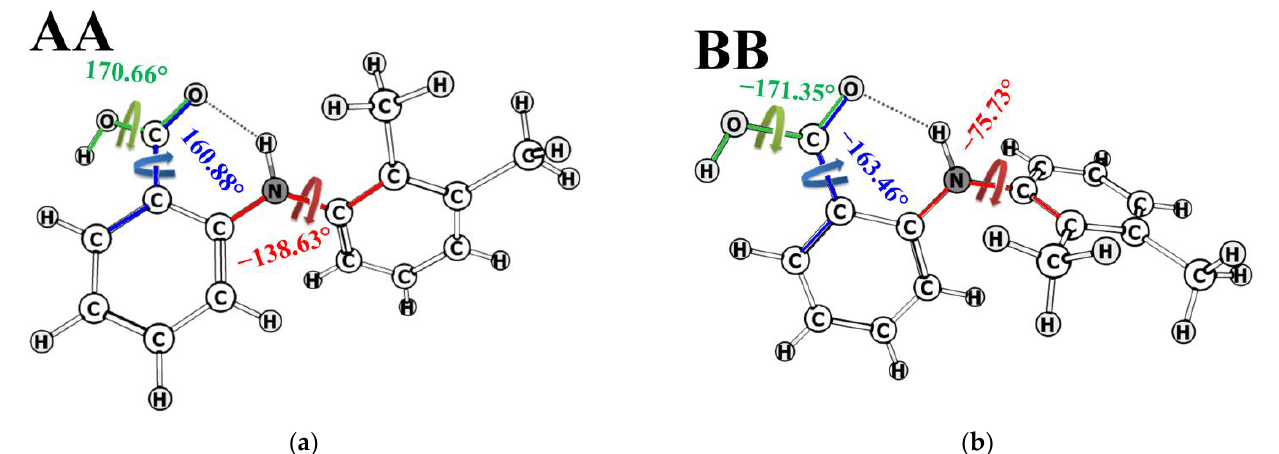
Figure 8. Structure of MFA conformers AA ( a ) and BB ( b ) and dihedral angles τ 1 [C 2 -N-C 3 -C 7 ] (red), τ 2 [O=C 1 -C 13 -C 6 ] (blue), and τ 3 [O=C 1 -O-H] (green arrow).